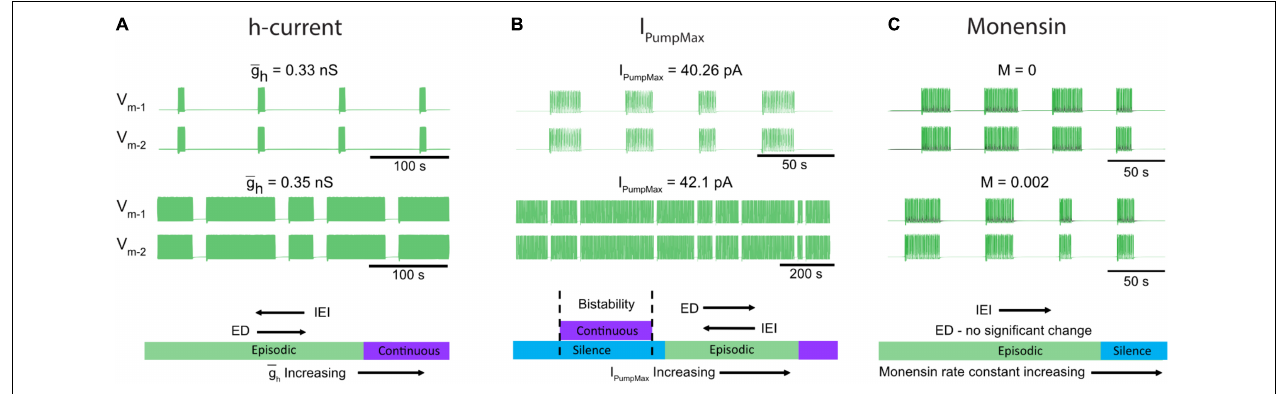
FIGURE 8 | Neuromodulators evoke diverse rhythmic outputs by moving the network through an excitation-based parameter space by altering I PumpMax , and g h . (A) Two traces showing behavior of the model while altering the h -current. (B) Changes in episodic activity following manipulation of I PumpMax and (C) model output before and after the introduction of a monensin factor. The bottom schematics (A–C) summarize the changes in rhythmic characteristics following manipulation of the h -current and I PumpMax , or through introduction of a monensin